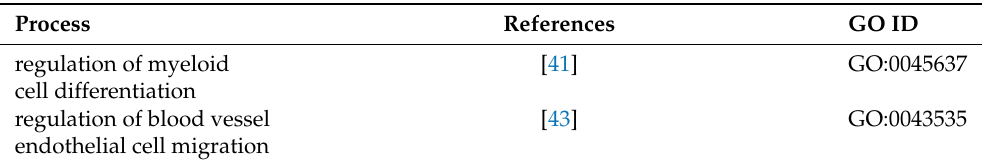
Table 3. GO terms of the biological processes selected by up-regulated TF-DEGs returned by Method 2. We note that as opposed to Method 1, the selection comprises just a few terms. Furthermore, only one term (GO:0045637) appears to be strictly correlated to CML.